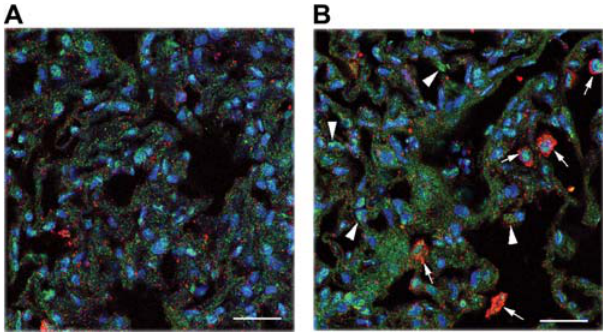
Figure 9. Immunohistochemistry dual staining for GADD45 a and MMP8. Wild-type animals were stained for GADD45 a and MMP8 prior to (A) and following mechanical ventilation (10 ml/kg, 8 hours), (B). Both gene products showed increased expression following ventilation. The staining pattern suggests cytosolic staining in multiple cell types for GADD45 a and staining for MMP8 restricted to inflammatory cells at the cell membrane. Large arrowheads indicate GADD45 a staining cells. Small arrows indicate MMP8 staining cells. Green stain=GADD45 a , red stain=MMP8, blue stain=counter nuclear staining. 40-fold magnification, scale bar=50 micrometer.